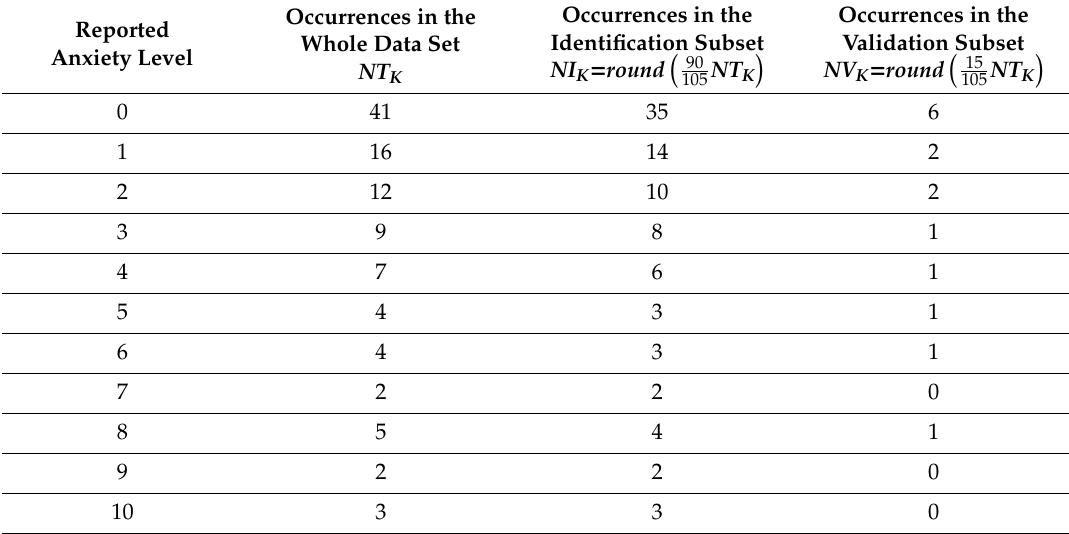
Table 4. Distribution of the reported anxiety